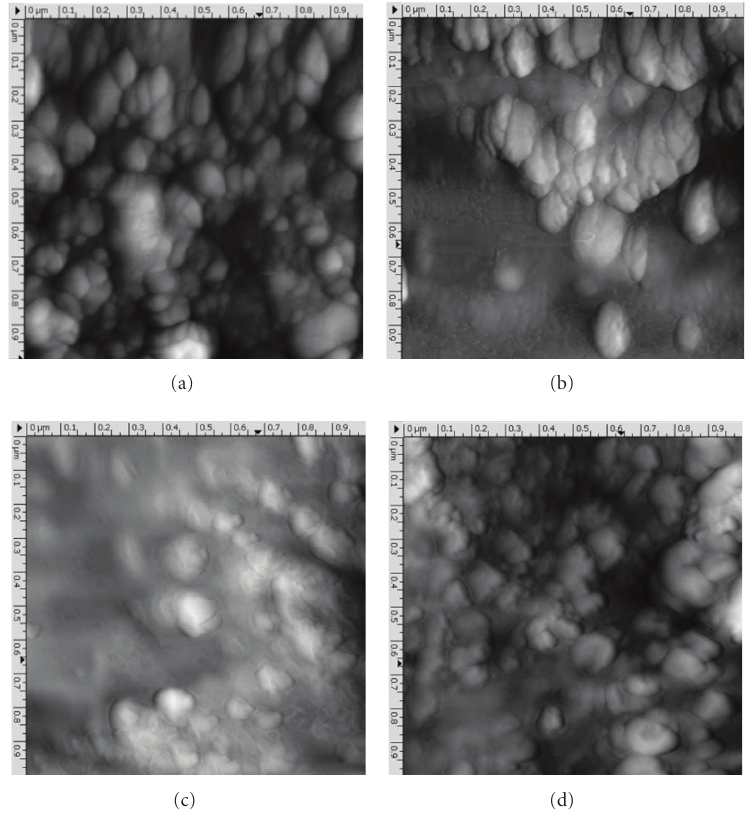
Figure 4: 2D AFM images of TiO 2 thin films on stainless steel substrate: (a) TiO 2 ; (b) 0.3% Fe-TiO 2 ; (c) 0.5% Fe-TiO 2 ; (d) 0.7% Fe-TiO 2 . Table 3: Specific rate comparisons with other studies for the photocatalytic degradation of toluene.